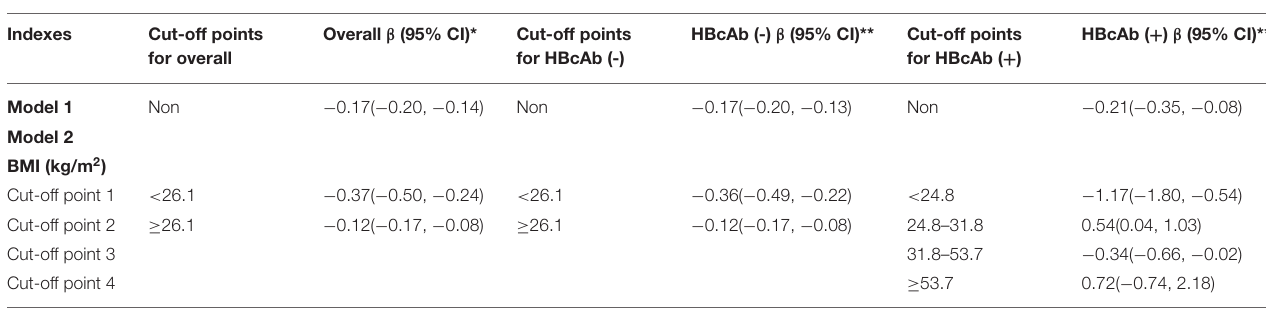
TABLE 4 | Cut-off points and segmentation effects for BMI (kg/m 2